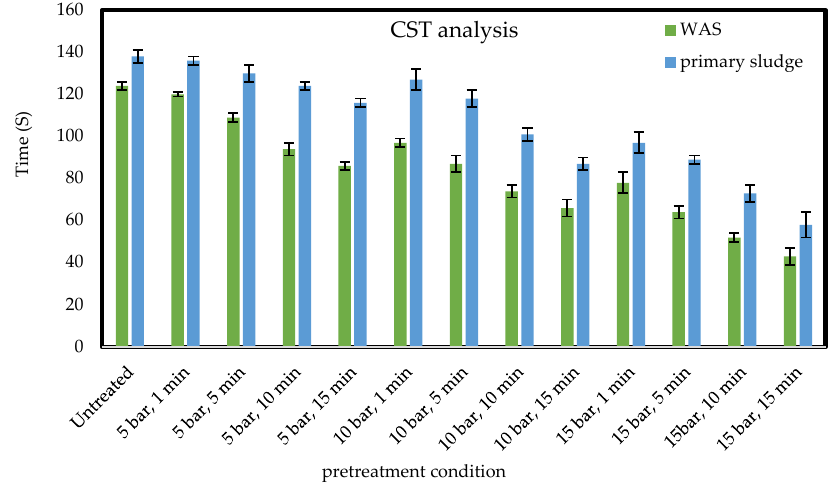
Figure 4. E ff ects of steam explosion pretreatment on capillary suction time (CST) of PS and Figure 4. Effects of steam explosion pretreatment on capillary suction time (CST) of PS and WAS.